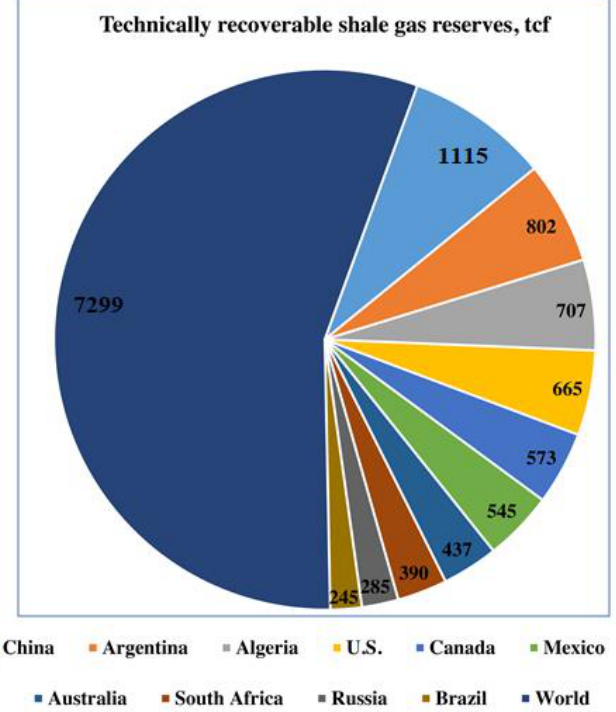
Figure 1. Global projection of technically recoverable shale gas reserves in trillion cubic feet (TCF). The leading global countries are shown in different colors. Reproduced with permission from [3] Copyright 2016 Elsevier.